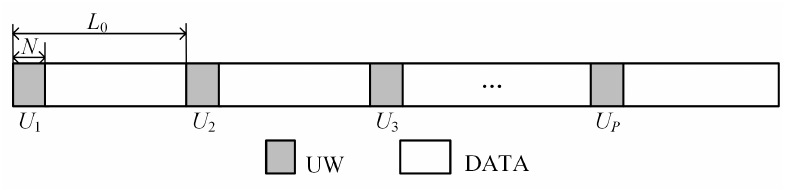
Figure 2. Distributed unique word TDMA frame structure.